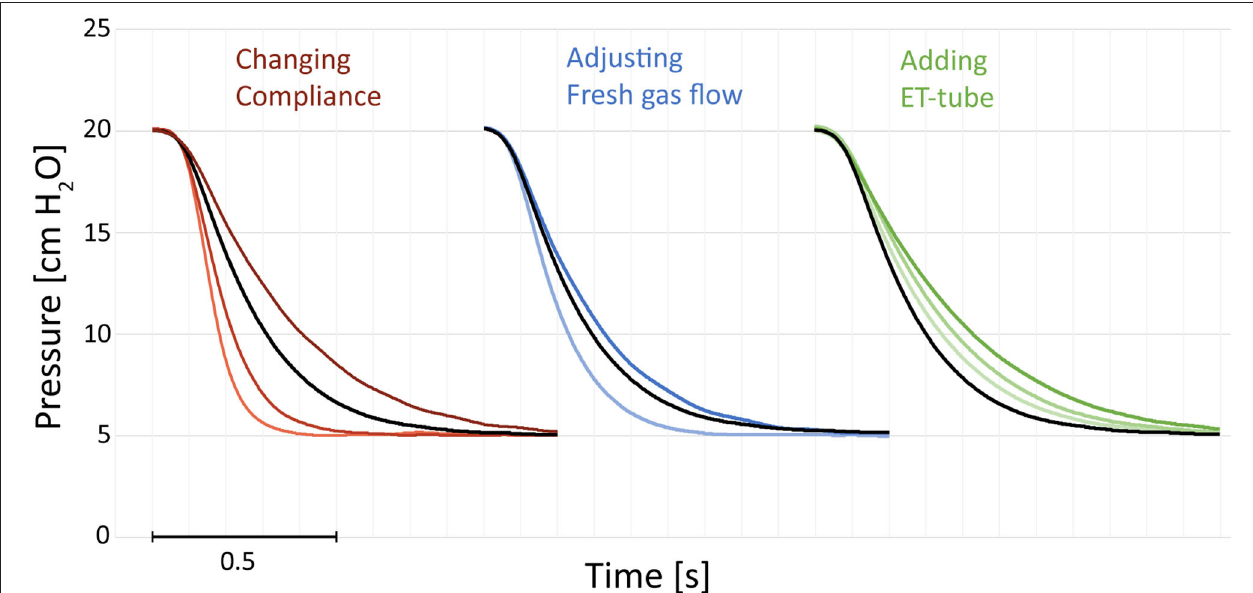
FIGURE 1 | Examples of pressure recordings of single expirations. The figures illustrate the effect of compliance, resistance added by a change in fresh gas flow or adding an endotracheal (ET) tube. Increased compliance (darker red) increases the expiratory time. Decreasing the fresh gas flow (darker blue) increases the expiratory time. Adding an ET-tube increases the expiratory time (green). Black reference recorded with compliance 2.2 mL/cm, no ET-tube, and 10 L/min fresh gas flow. All recordings at 5cm H 2 O and an airway resistor Rp50 with 20cm H 2 O of peak inspiratory pressure. The single expirations have been graphically adjusted in time (X-axis) and were recorded